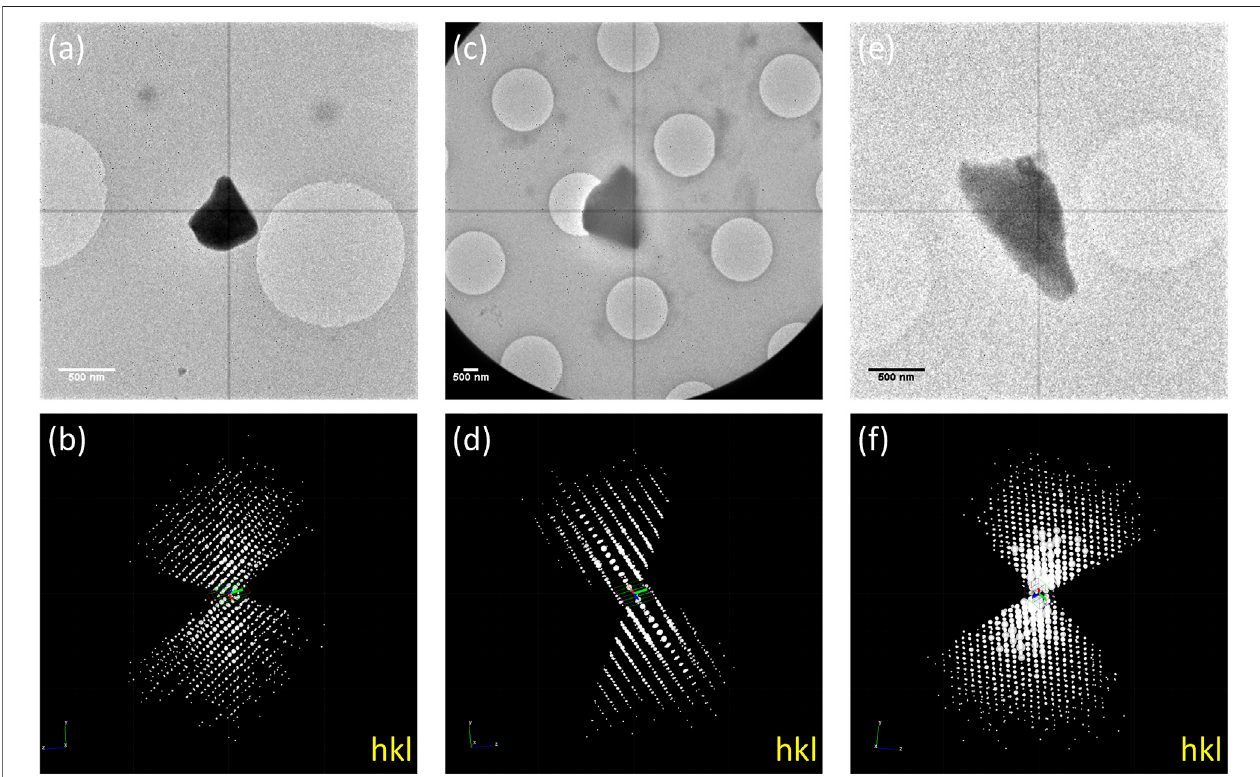
FIGURE1| TEMimagesof (A) 1-Nitrobenzene, (C) 1-Cyclohexane,and (E) 1-Guaiazuleneandthe3Dreciprocallatticeof (B) 1-Nitrobenzene, (D) 1-Cyclohexane, and (F) 1-Guaiazulene.